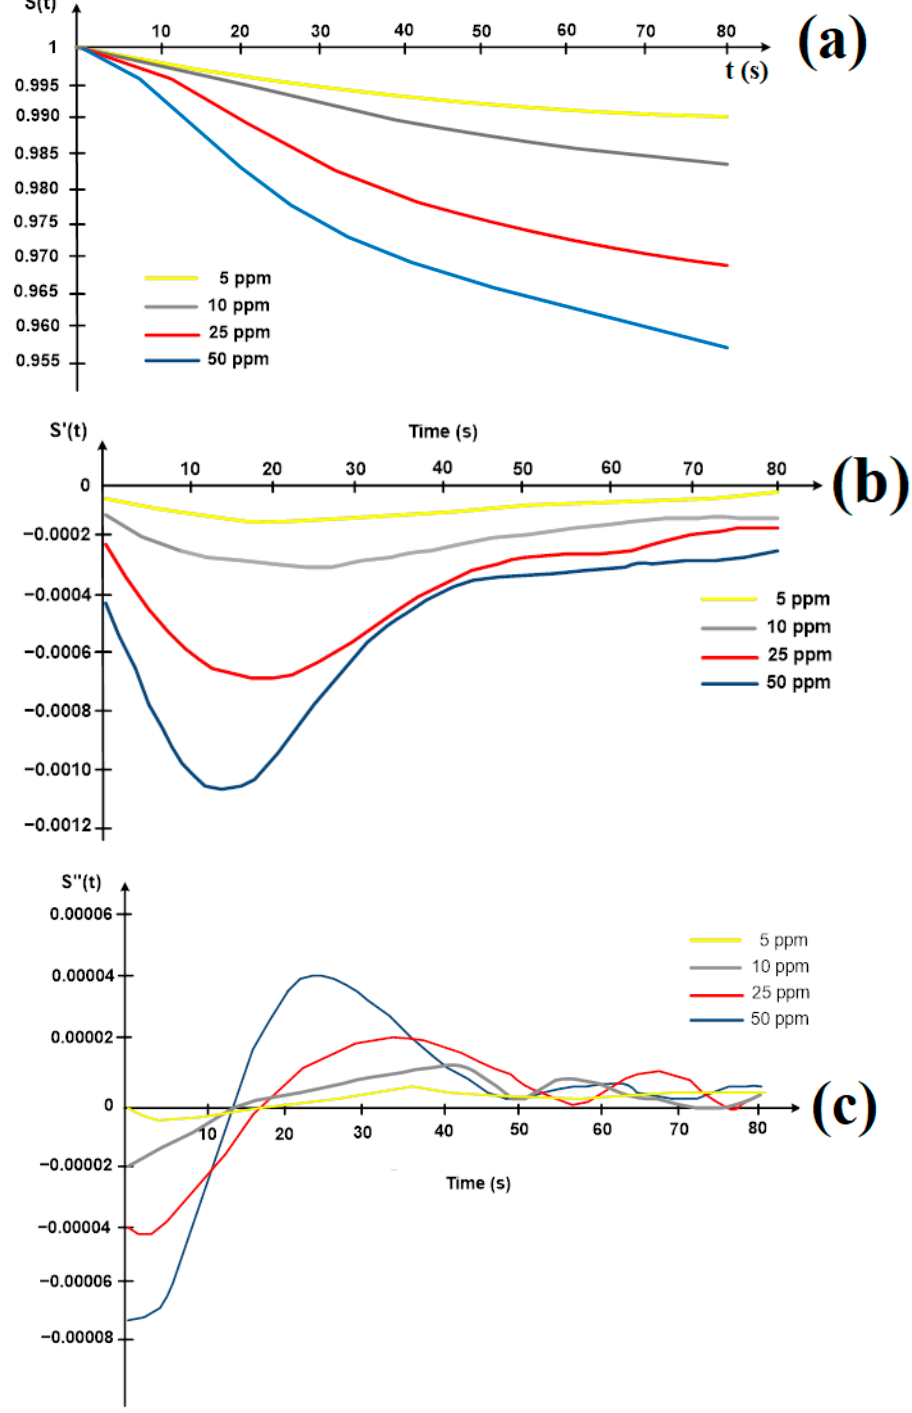
Figure 4. The kinetics ( a ) of the Type 1 gas sensor response S ( t ); ( b ) of the first derivative S ( t ); ( c ) of the second derivative S ( t ) at different NO 2 concentrations.